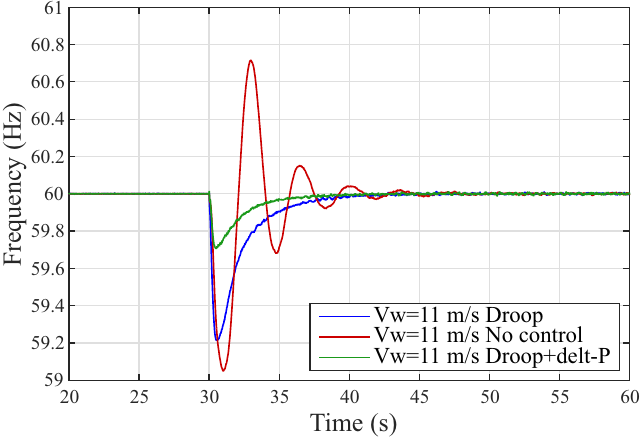
Figure 10. Frequency comparison for wind speed of 11